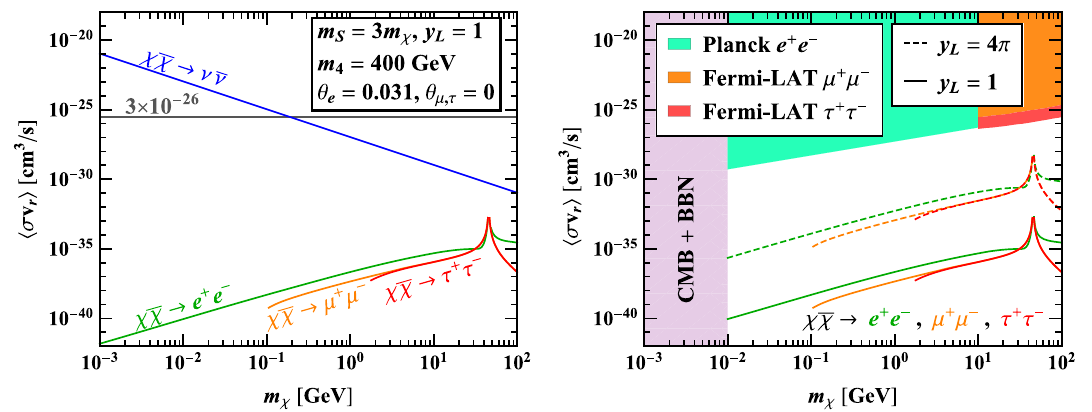
Fig. 4 Thermally averaged annihilation cross section multiplied by the relative velocity for DM annihilation into e + e − , μ + μ − , and τ + τ − . We have fixed m S = 3 m χ , m 4 = 400 GeV, y L = 1, θ e = 0 . 031, and θ μ,τ = 0. The left panel provides comparison with (cid:2) σv r (cid:3) for DM